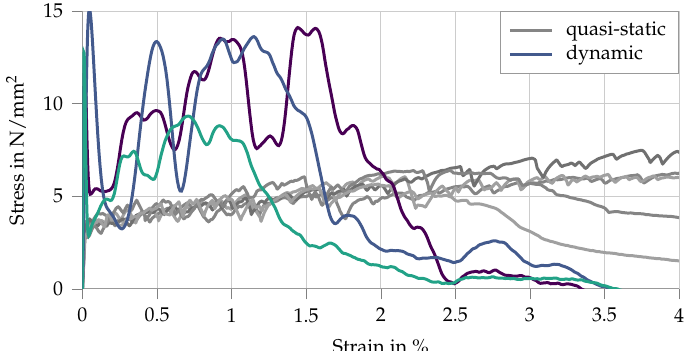
Figure 7. Experimental stress–strain curves for a split Hopkinson bar tension test with SHCC, data from [5,27]. The quasi-static results are given in gray as a